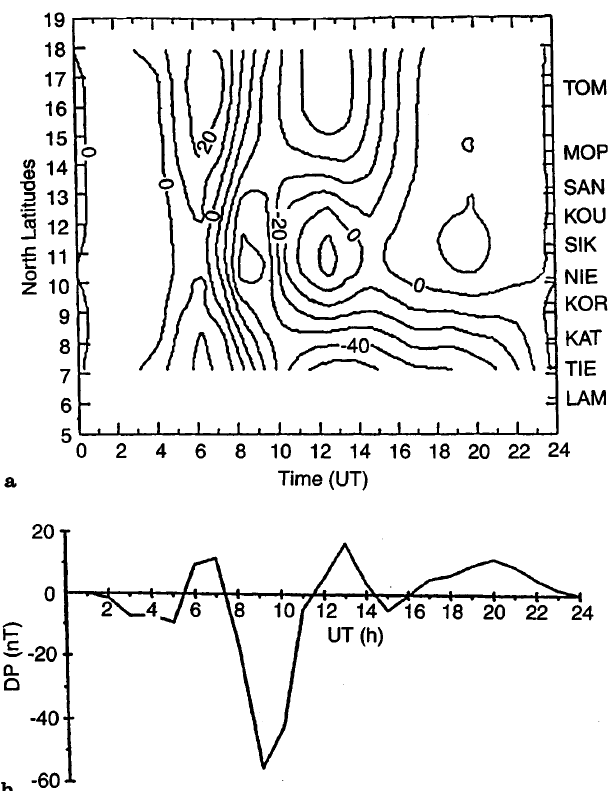
Fig. 10. a Isofield contours of DP equivalent currents variations inferred from H variations at the equator for the ten magnetic stations of the African network and b DP variations inferred from H variations